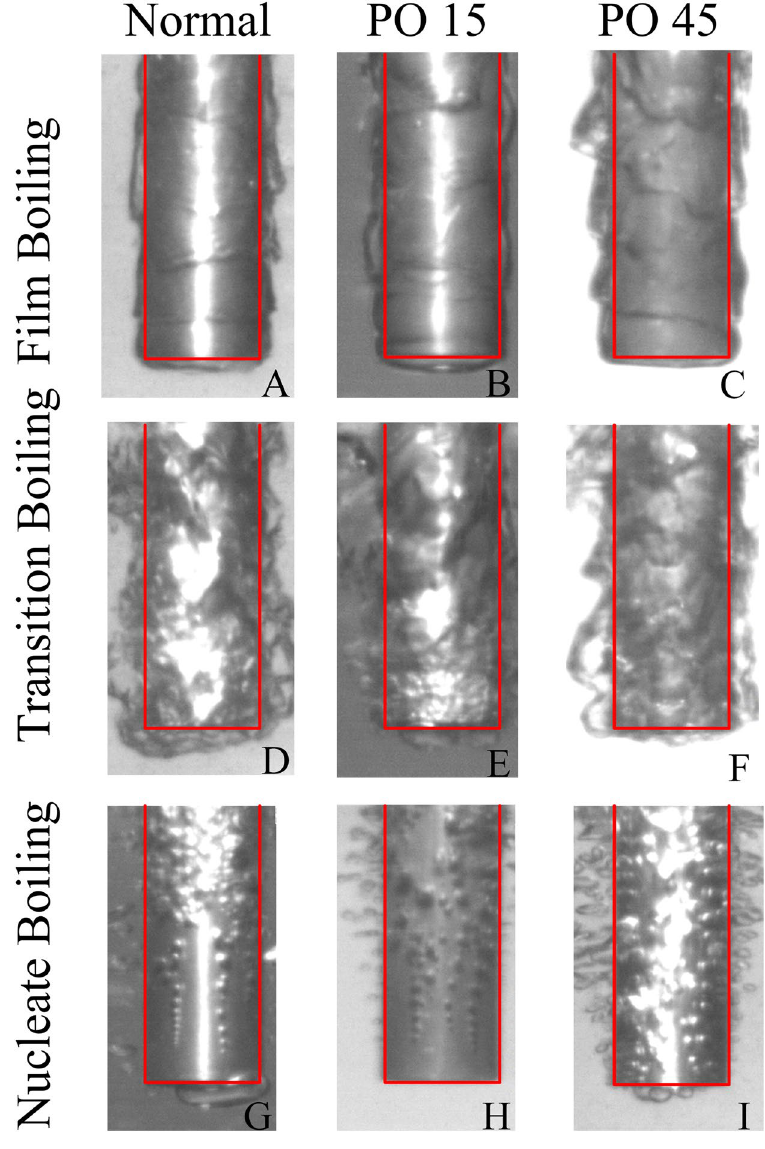
Figure 7. Comparison of the liquid-vapor flow patterns formed on conventional (left column) and nanoporous surfaces (middle and right columns) during liquid nitrogen quenching. ( A , B , C ) Film boiling regime; ( D , E , F ) Transition boiling regime; ( G , H , I ) Nucleate boiling